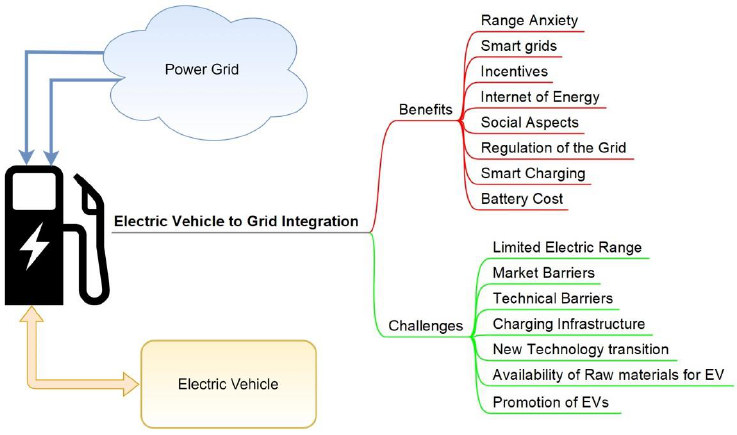
Figure 6. Key benefits and challenges as per the recent literatures . Table 2. Benefits of electric vehicle grid integration as per the recent literature .